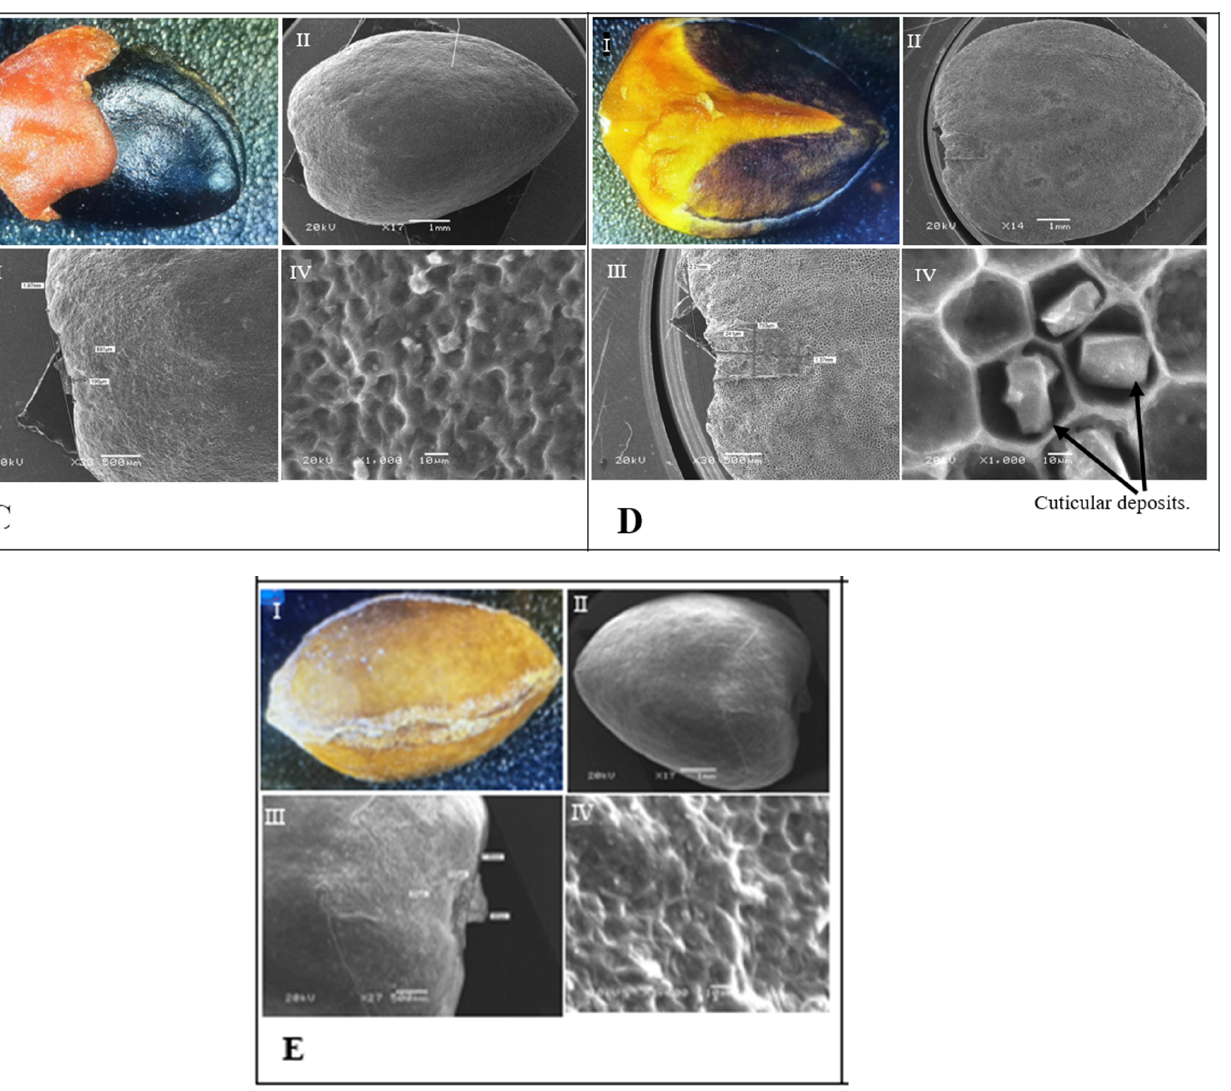
Figure 11. Seeds of Commiphora sp.: ( A ) C. erythraea , ( B ) C. gileadensis , ( C ) C. kataf , ( D ) C. myrrha , and ( E ) C. quadricincta ; I: LM figure magnified at X1.7, II: SEM figure shows the whole seed, III: hilum area, as seen by SEM, IV: overall pattern of ornamentation, as seen by SEM.